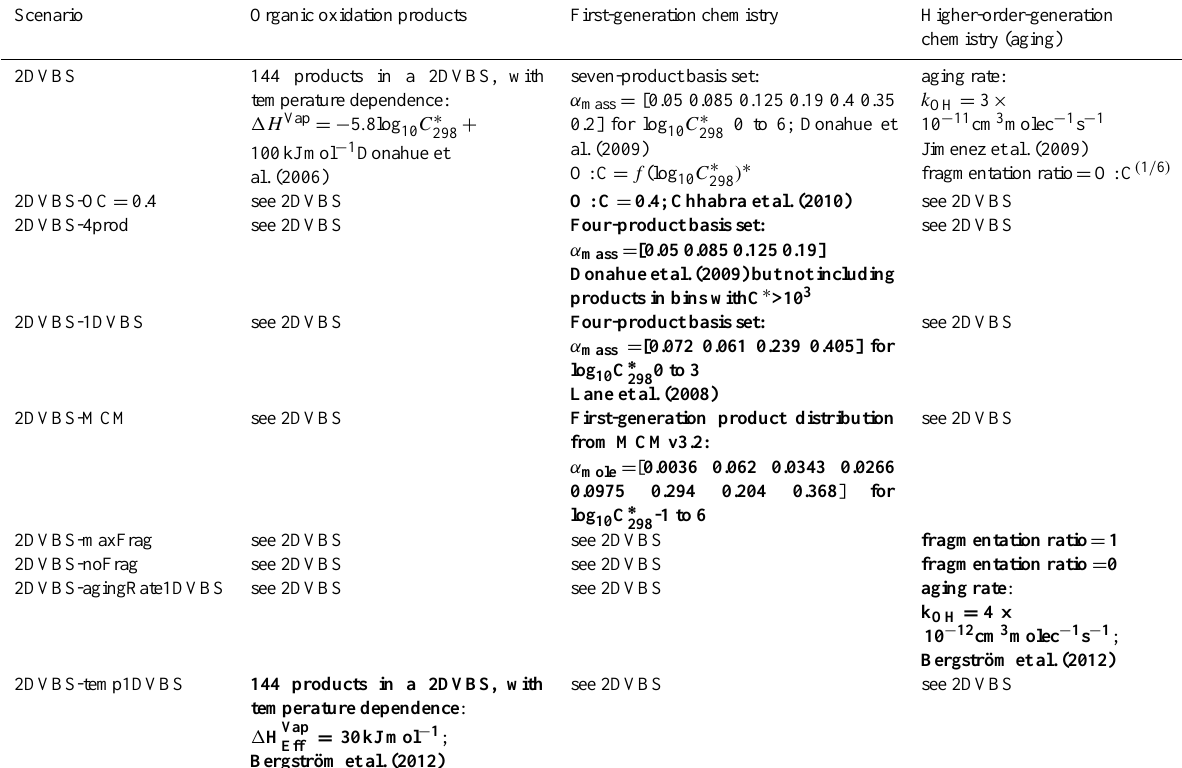
Table 3. Sensitivity test performed on the 2DVBS base case (top row). Changed parameters are described in bold text, all other parameters are kept